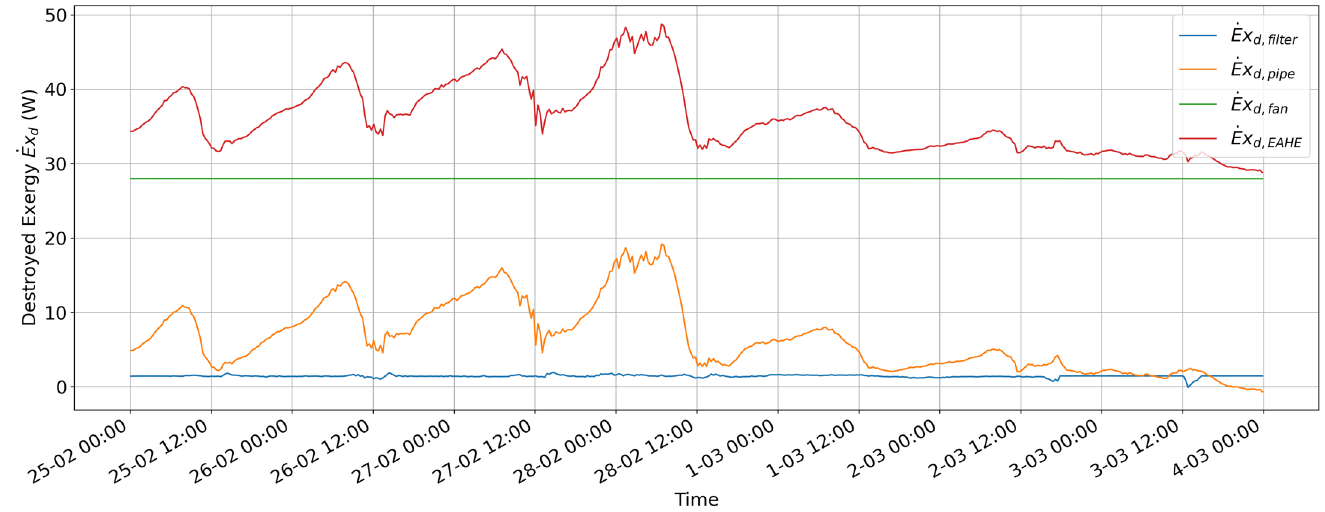
Figure 6. Exergy destroyed in each component of the system during the analysis period.